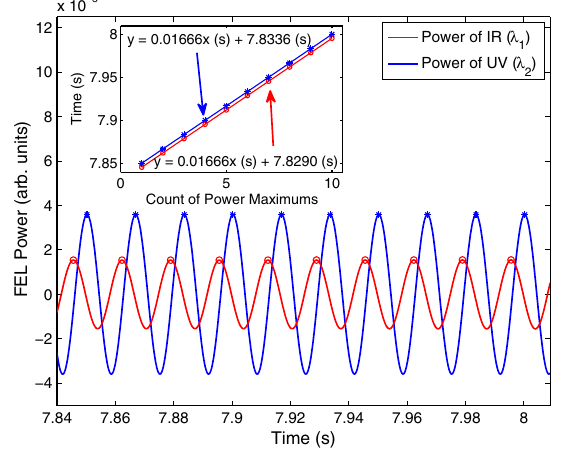
FIG. 15. Filtered 60-Hz ac component of the power data shown in Fig. 14(a) after applying a numerical bandpass filter (59.54 Hz – 60.54 Hz). The slopes in the inset represent the period of the ac components (0.01666 s, corresponding to 60.01 Hz), and the intercept difference between two linear fittings (4.7 milliseconds) represents the phase difference ( 0 . 56 π rad) between this ac component in the two-color power